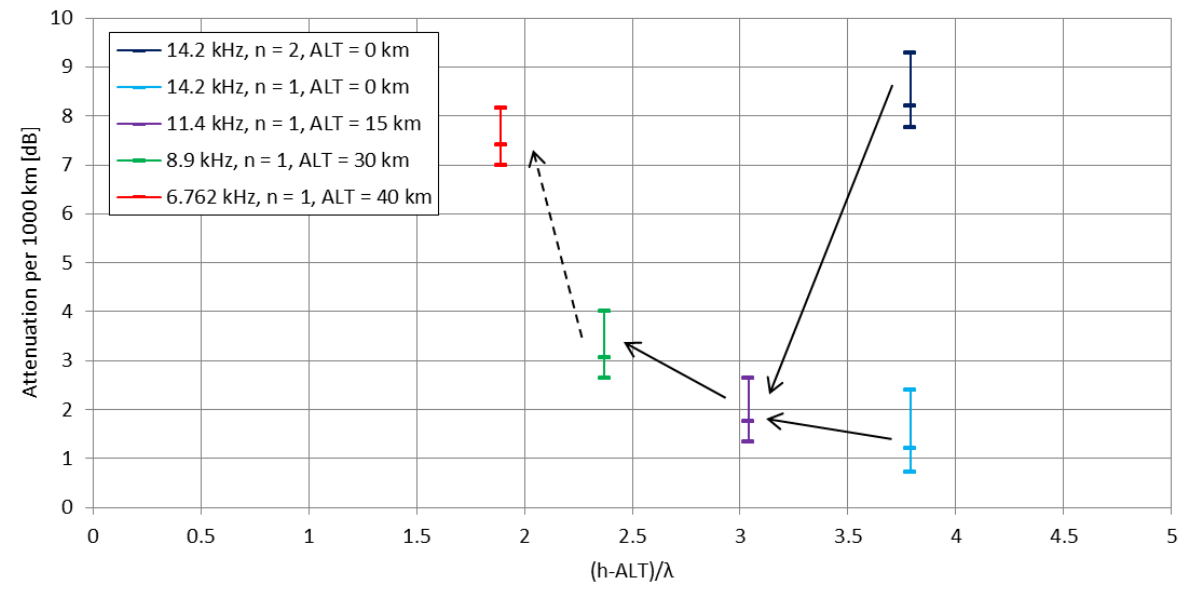
Figure 4. The ranges of propagation modes’ attenuations per 1000 km, plotted for ionospheric height-to-wavelength ratio modified for stratospheric altitudes, presenting ‘modified’ transmitting frequencies. The parameter ‘ n ’ indicates the mode number; the attenuation per 1000 km for each mode has its limits (on the plot: short horizontal markers) depending on the ground conductivity: upper limit for 2 mS/m, lower limit for infinite conductivity, middle value for 20 mS/m. The black arrows indicate the change of modal composition and attenuation for rising altitude; solid black lines indicate altitudes easily reachable by light stratospheric balloons, dashed black line indicates the waveguide symmetry-plane altitude.